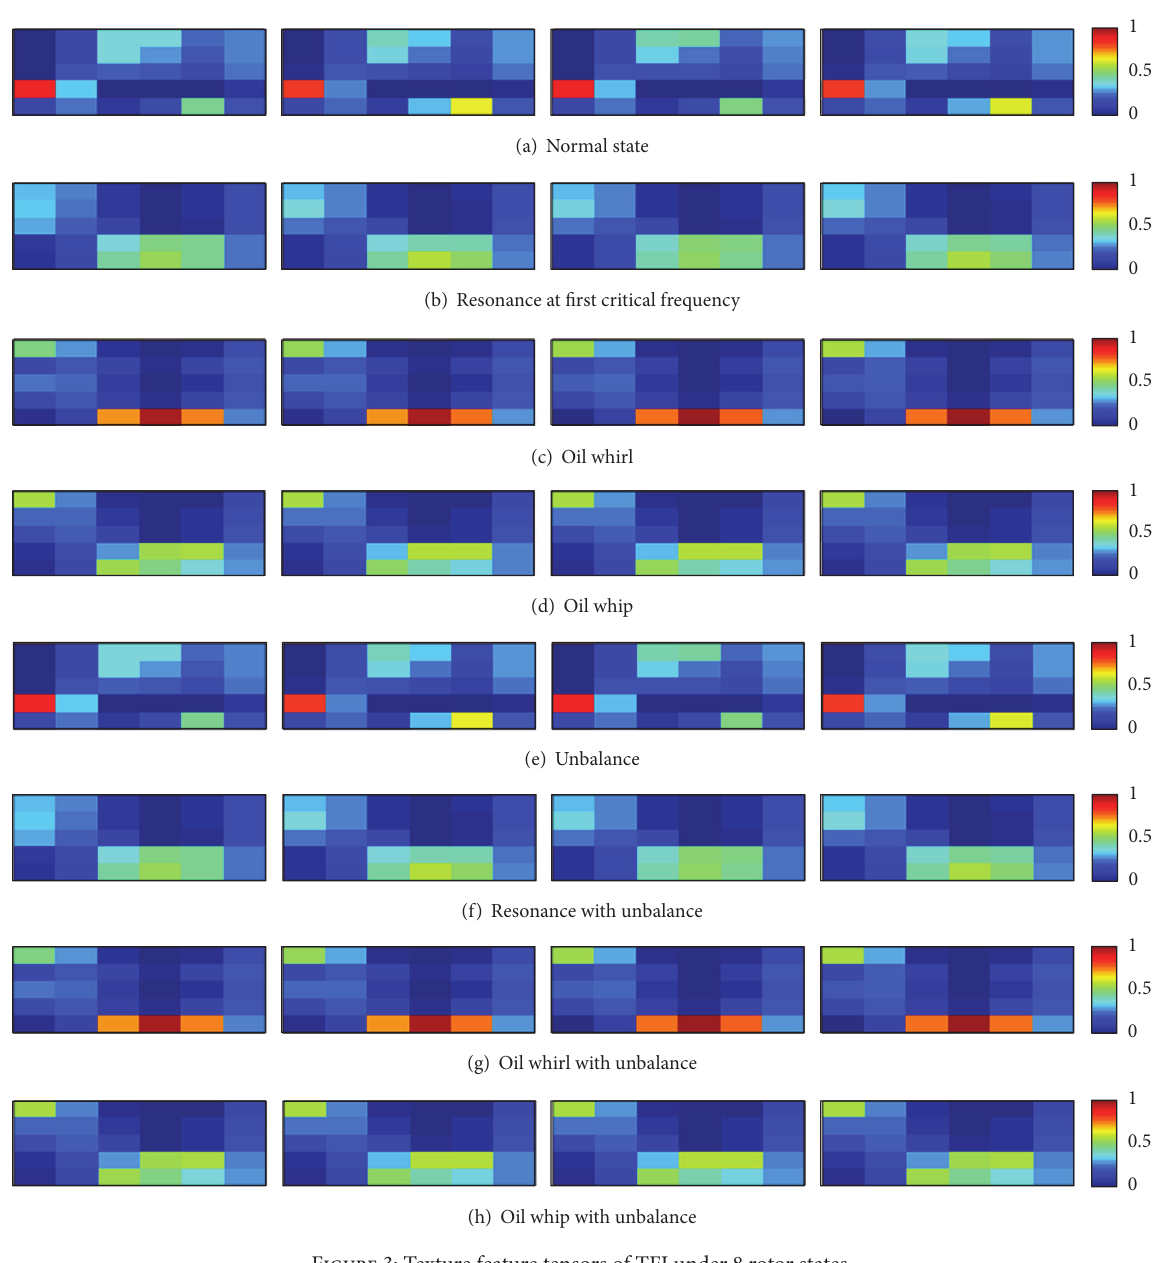
Figure 3: Texture feature tensors of TFI under 8 rotor states. Table 2: Recognition results of rotor